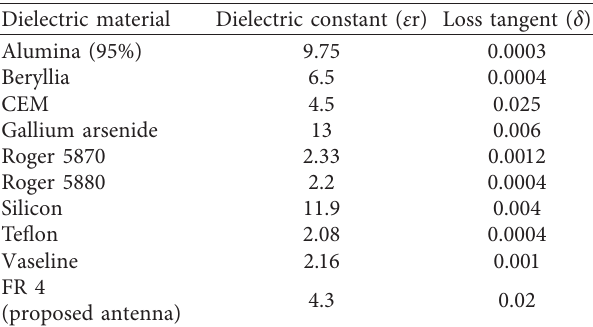
Table 2: Various dielectric materials with dielectric constants and loss tangent